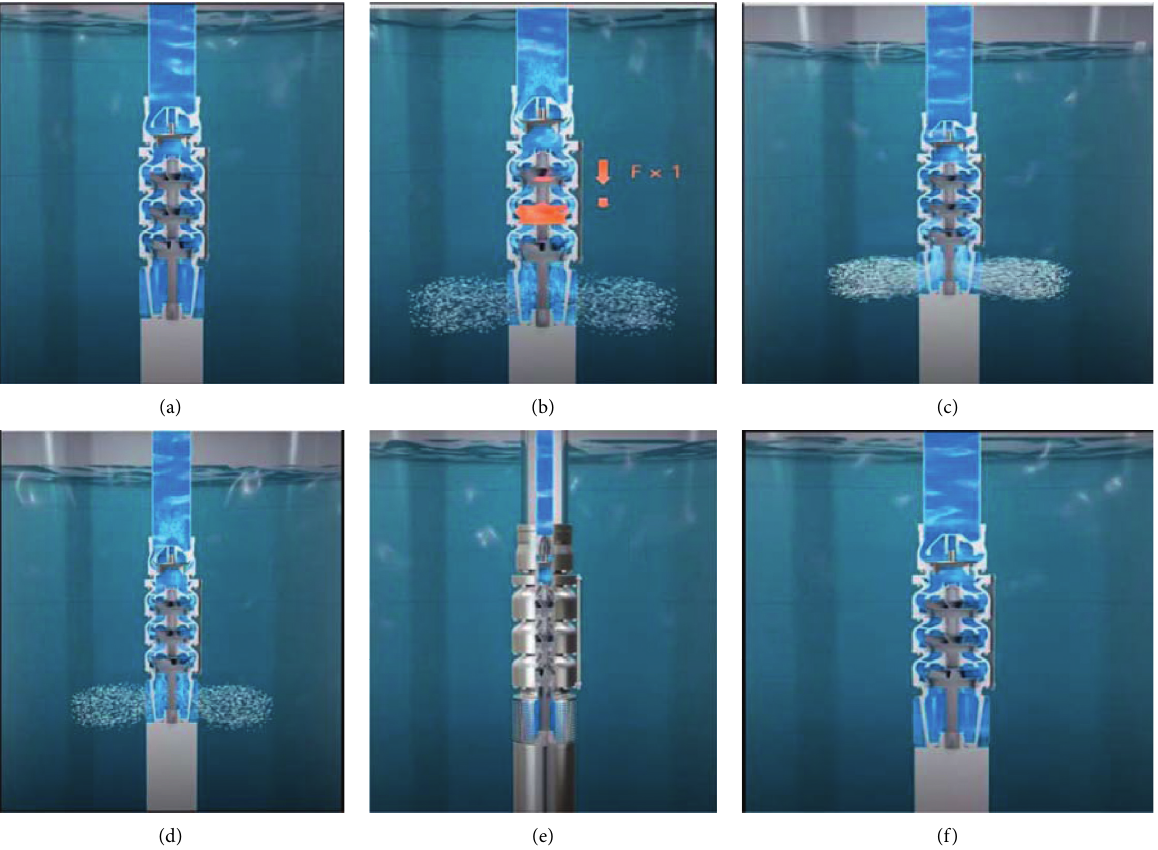
Figure 1: Lifting process of hydraulic support (from Google: